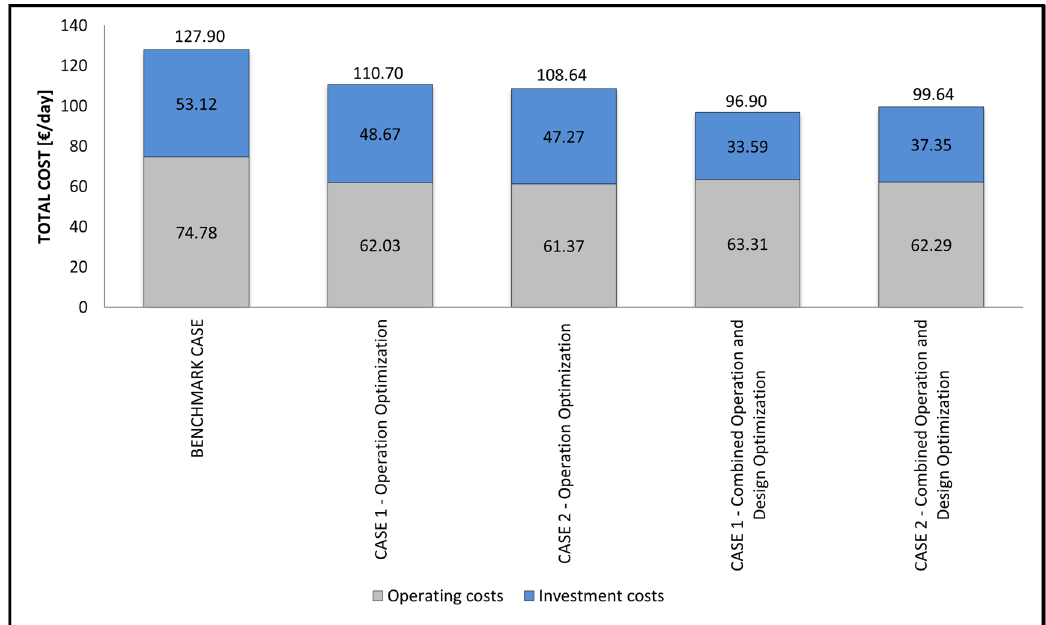
Figure 16. Daily cost for operations and investment for the Operational Optimization (for both Case 1 and Case 2) and Combined Design and Operation Optimization (for both Case 1 and Case 2) with a biogas price equal to 0.22 €/m 3 .